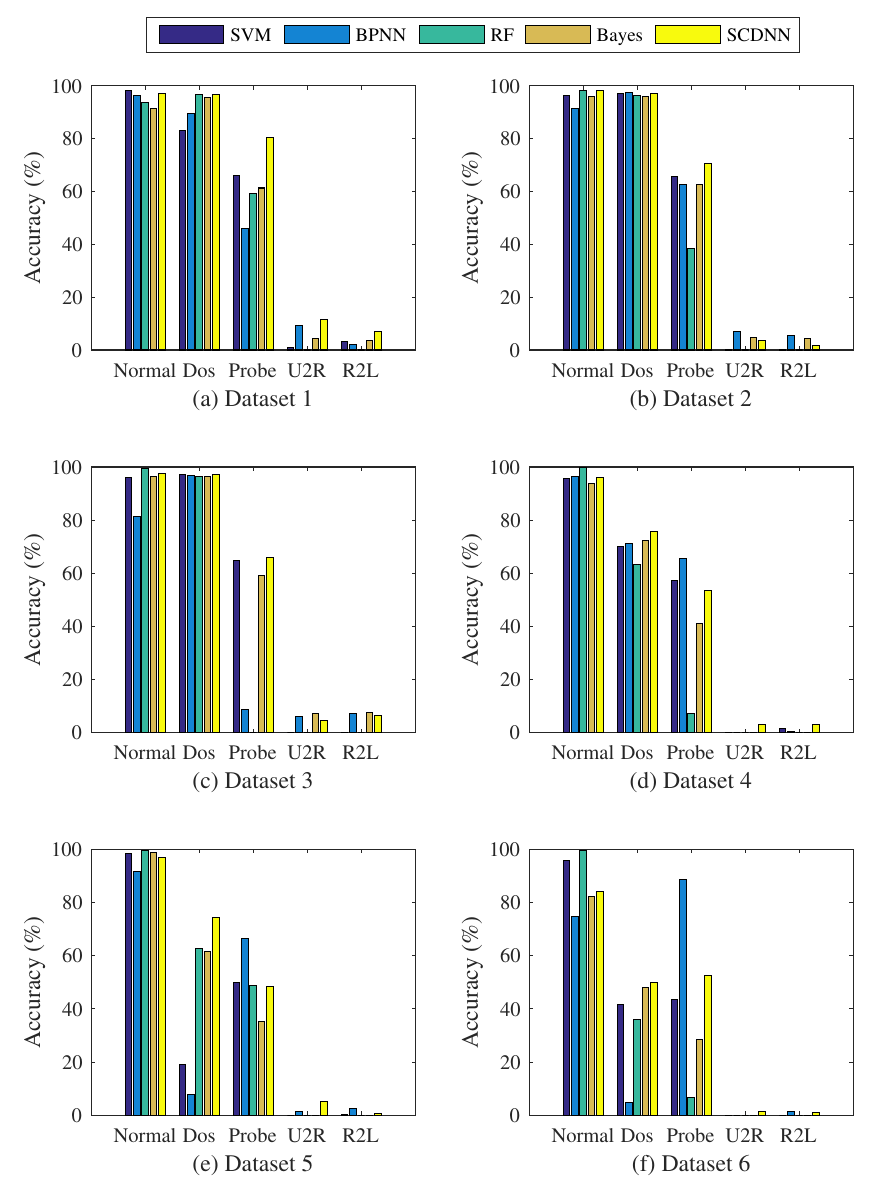
Figure 5. ( a–f ) Prediction accuracy histogram of the five detection